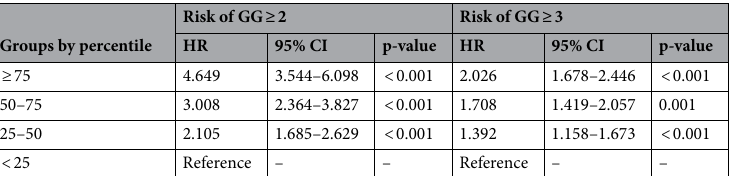
Table 2. Risk of GG ≥ 2 and GG ≥ 3 relative to the low-risk group (PRS < 25th percentile). GG grade group, HR hazard ratio, CI confidence interval.